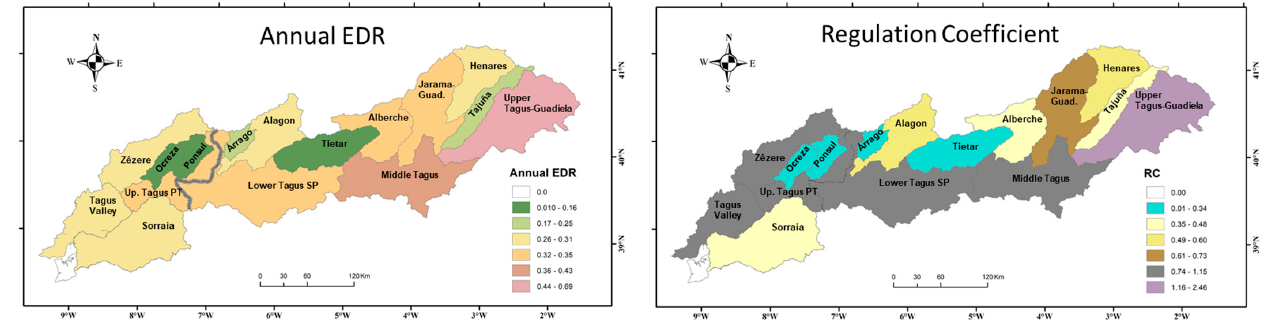
Figure 4. The regulation coefficient values and the average annual EDR values for the historical scenario of streamflows and existing infrastructure.